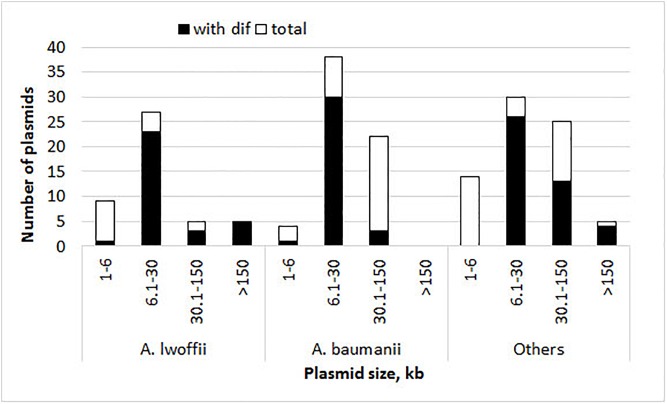
Histograms of plasmid size and their numbers with and without pdif sites. The height of the column indicates the total number of plasmids, and its black part shows the number of plasmids containing pdif sites.